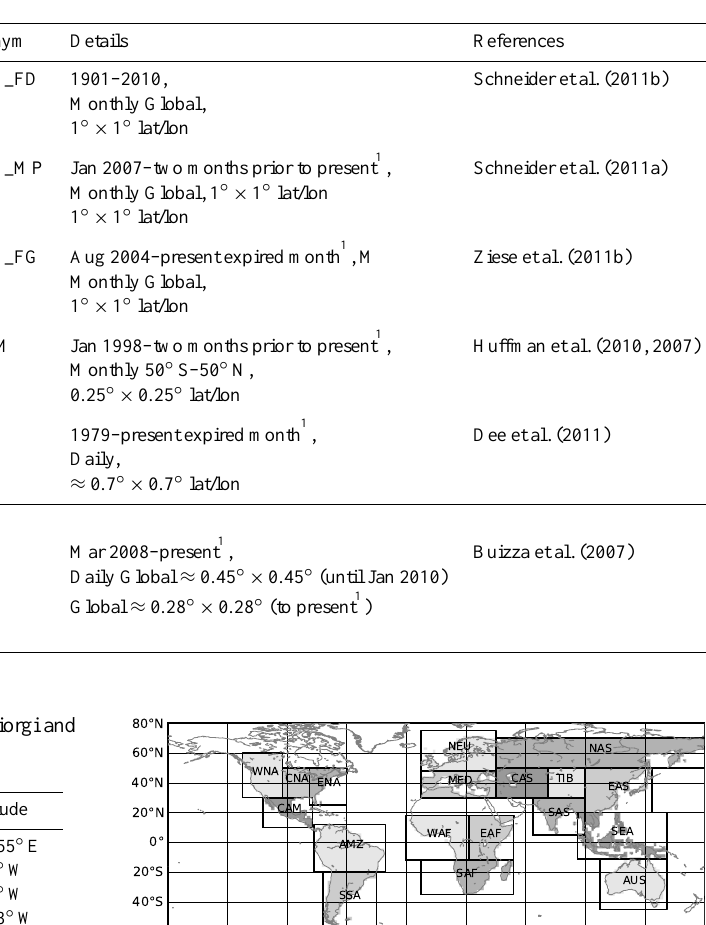
Table 1. Precipitation products description.